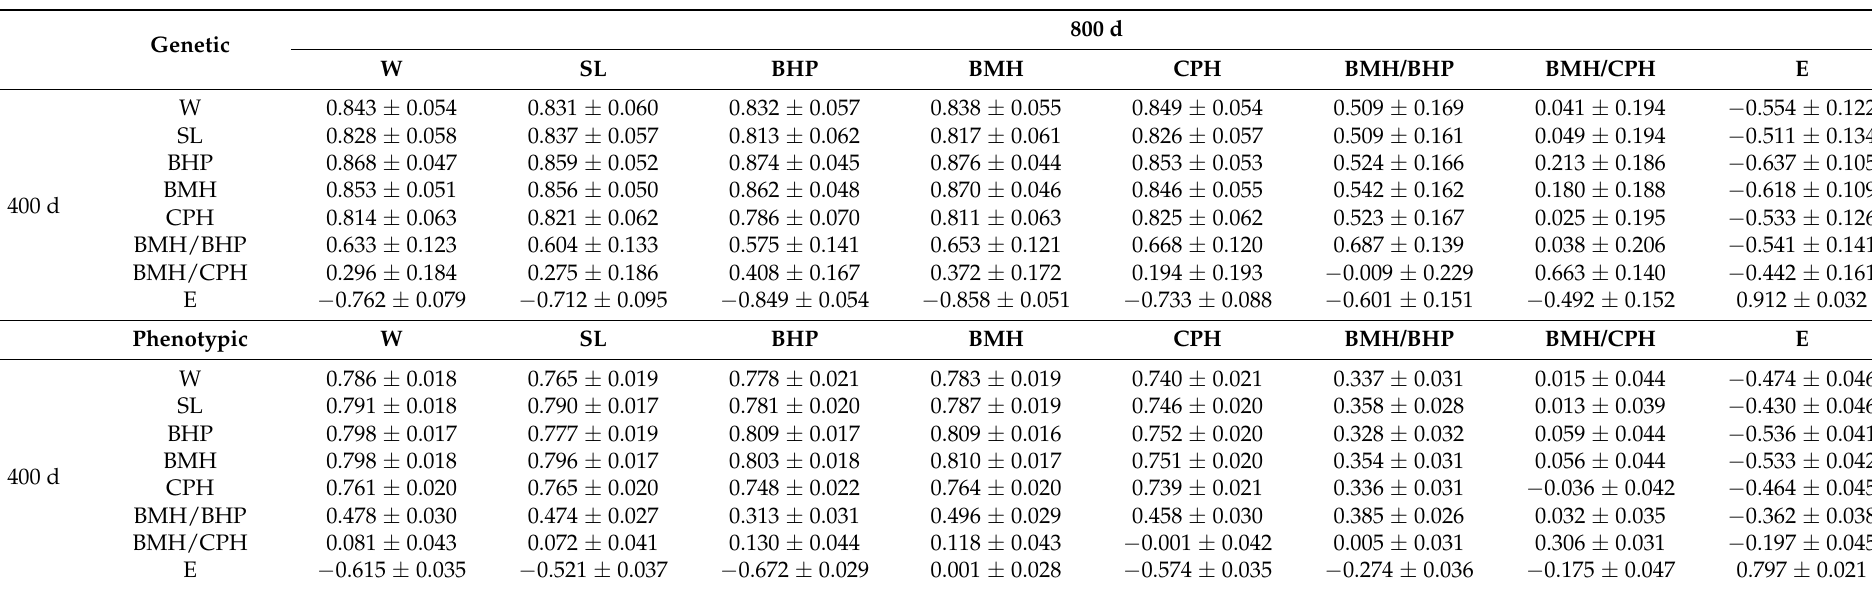
Table 3. Genetic (top) and phenotypic correlations between 400 (left) and 800 days (d) (right) for growth traits (weight (W) and standard length (SL)), heights (body height at the insertion of the pectoral fin (BHP), body maximum height (BMH) and caudal peduncle height (CPH)), height ratios (BMH/BHP and BMH/CPH) and ellipticity (E).